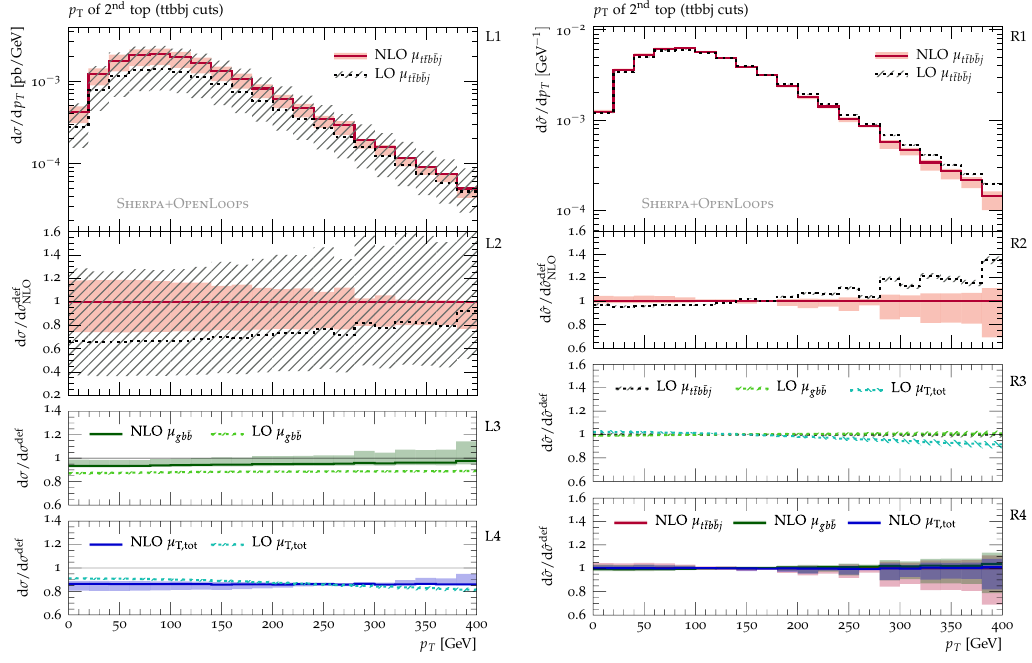
Figure 12. p T of the softer top. Same setup and plots as in (cid:12)gure 8.